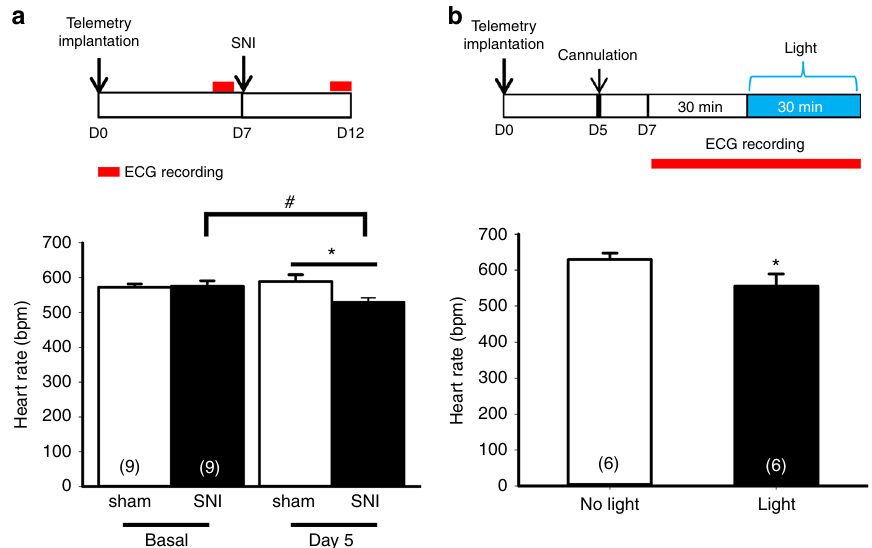
Fig. 9 SNI surgery and optogenetic activation of PVA neurons reduce heart rates in mice. a Schematic of experimental design showing the timeline for telemetry probe implantation (D0), ECG recording before SNI surgery (basal at D7), and ECG recording 5 day after SNI surgery (D12) ( upper panel ). Heart rates of animals subjected to sham or SNI surgery at basal or 5 days after surgery ( lower panel ). SNI surgery lead to a reduced heart rate compared to sham group or its own basal level. * p < 0.05 vs. sham group at day 5, # p < 0.05 vs. SNI basal state. b Schematic of experimental design showing the timeline for telemetry probe implantation (D0), cannulation (D5), and ECG recording for 30 min before and during blue light stimulation (D7) ( upper panel ). These animals were infused with AAV-CaMKII α -hChR2 (H134R)-eYFP vector in PVA for 6 – 8 weeks before telemetry implantation. Optogenetic stimulation of PVA neurons lead to a reduction in heart rate compared to that of the same animal without light stimulation ( lower panel ). * p < 0.05 vs. no light stimulation. Error bars indicate SEM. Statistical signi fi cance was determined between sham and SNI group by Student ’ s t- test ( a ) or intragroup by Paired t- test ( a , b )